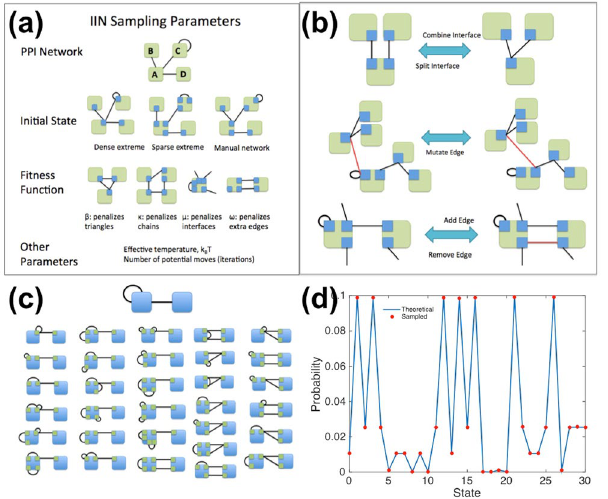
Figure 7. Interface networks for a given protein network can be sampled via Monte Carlo methods with or without bias. ( a ) Inputs and parameters for our stochastic IIN sampling model for a given PPIN that is not altered. ( b ) Monte Carlo reversible move sets (5 moves possible) to transition between IIN structures. ( c ) A two protein network with 2 PPIs can be enumerated into 31 distinct IINs when one extra edge is allowed. Moves between states were enumerated as a Markov chain to determine the factors necessary for detailed balance. ( d ) Proof of detailed balance in the toy model (C). The probability of being in a given state is proportional to its propensity e − f/kBT , where “f” is the assigned fitness penalty (low “f” = more fit) and k B T is set to 2. The blue line is the theoretical stationary distribution based on propensities, and the red circles are the MC sampled